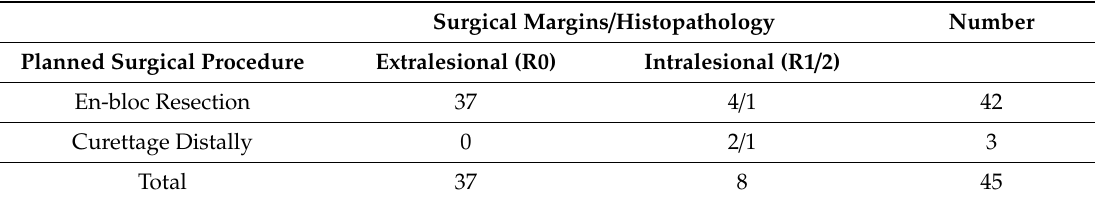
Table 3. Surgical margins and histopathological